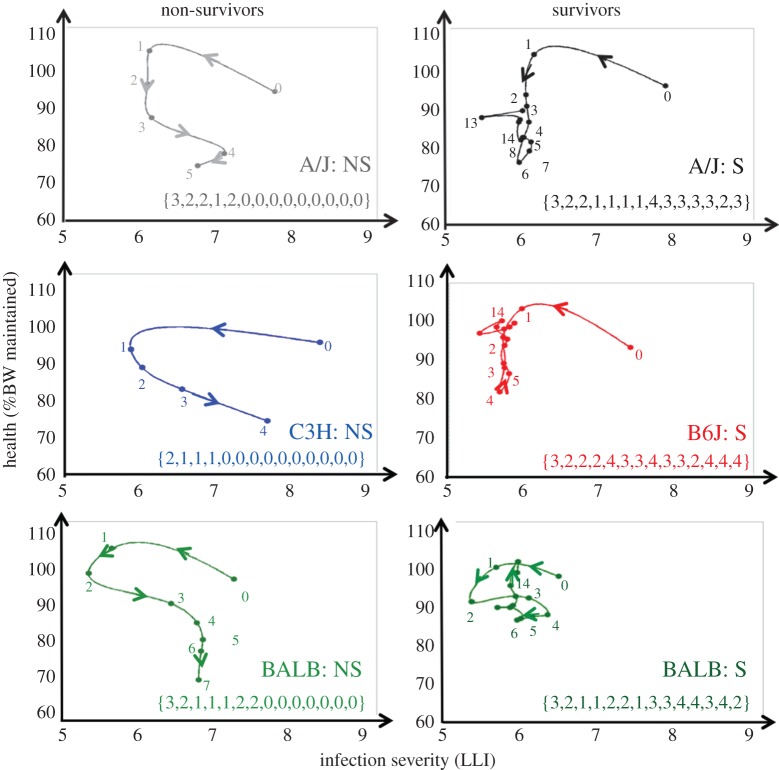
Representative trajectories for each mouse strain by survival outcome, together with the corresponding numerical sequence representing daily changes in infection severity and health (SH). We refer to figure 1 and the main text for explanation of the latter. The numbers in the trajectories denote the day at which the measurements were taken. ‘S’ and ‘NS’ denote survivors and non-survivors, respectively.